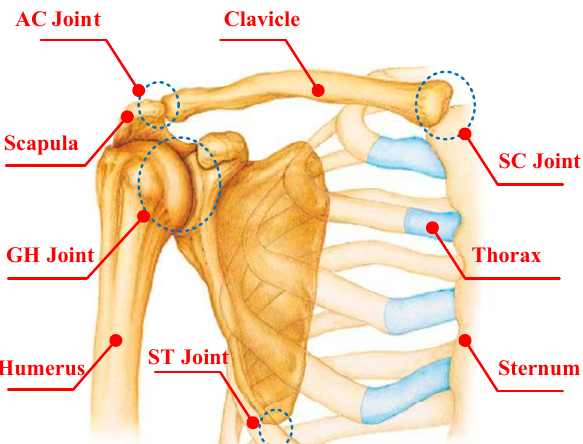
Figure 1. Anatomy of the shoulder complex (AC: acromioclavicular; SC: sternoclavicular; GH: glenohumeral; ST: scapulothoracic).